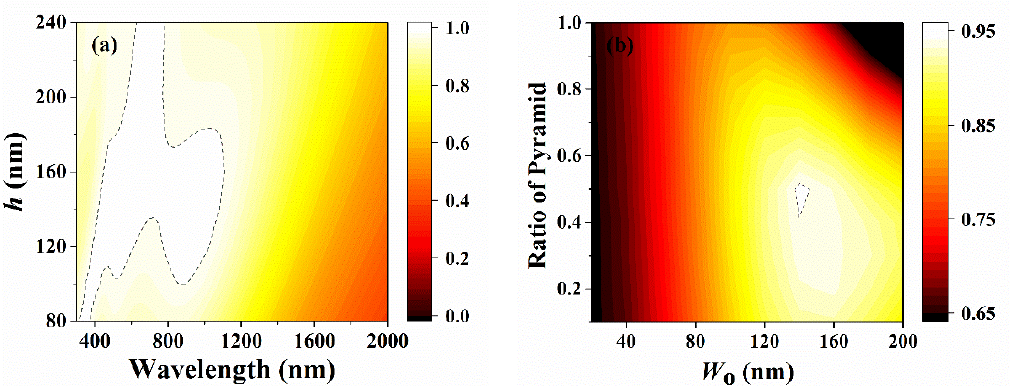
Figure 9. The geometric effects of the truncated pyramid resonator on the absorption performances: ( a ) The pyramid height ( h ), and ( b ) the ratio of the pyramid (i.e., W i / W o ) and the lower face ( W o ) of the pyramid.